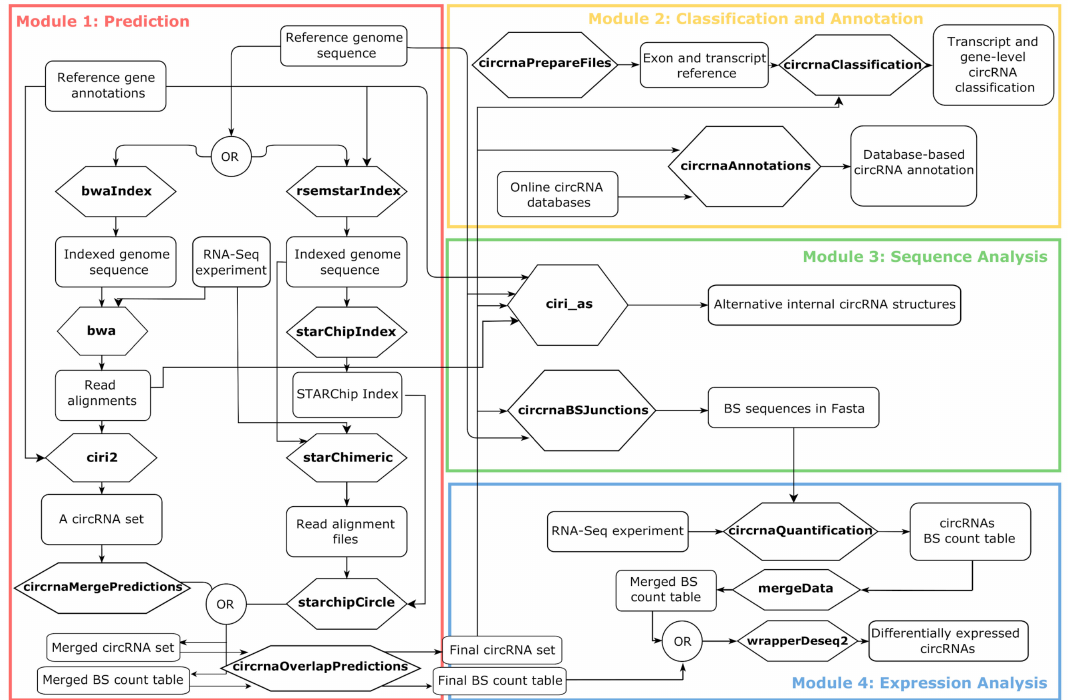
Figure 1. Schematic representation of the Docker4Circ modules with indication of all the functions (reported in bold in the hexagons) and the input / output files involved (reported in the squares). The di ff erent modules implemented in the framework are reported with di ff erent colors. BS =